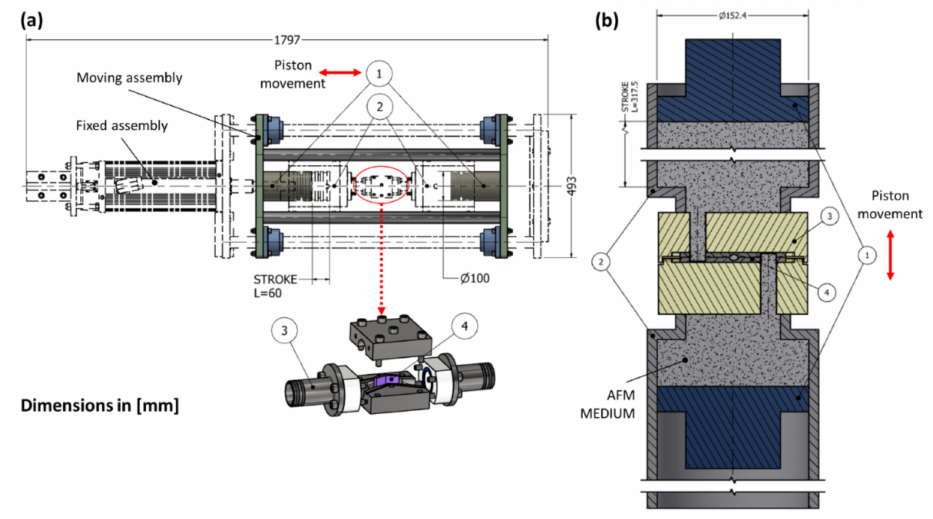
Figure 3. AFM setups: ( a ) V-shape laboratory setup; ( b ) S-shape industrial